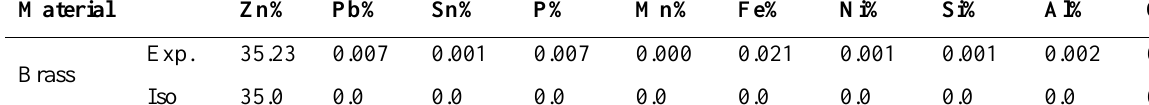
Chemical composition of Brass sheet (Iso- Cu Zn 65-35 426/1). Material